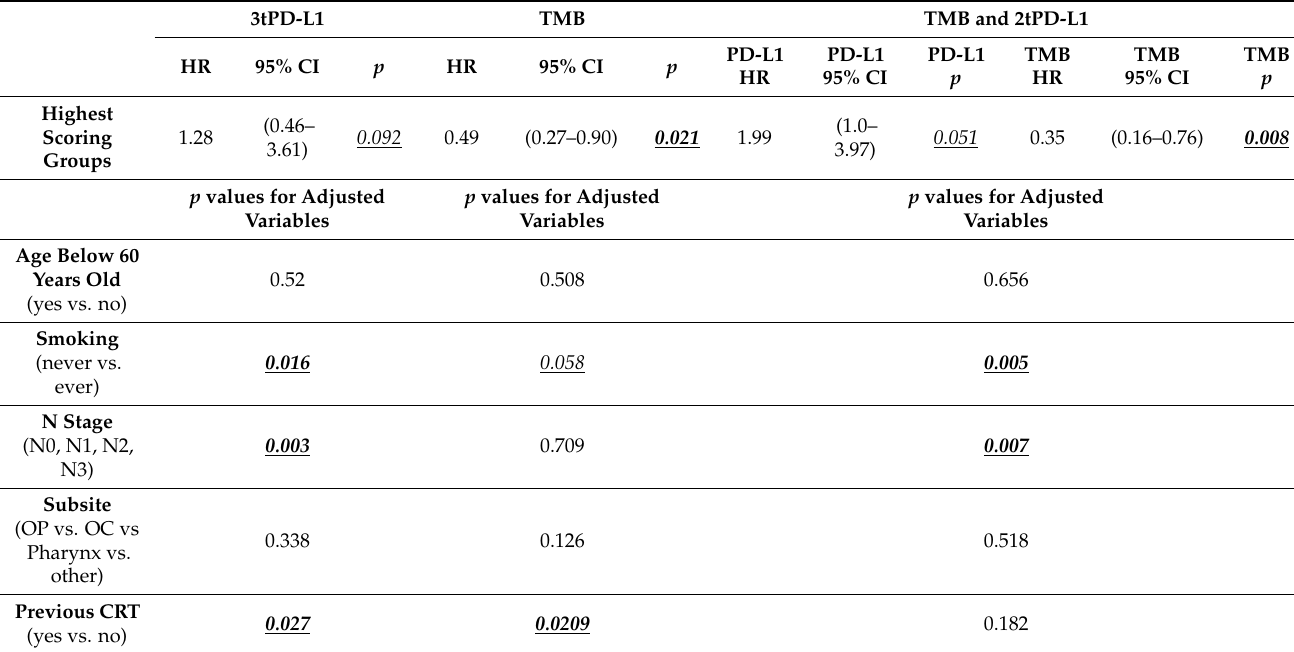
Table 4. Results from adjusted Cox proportional hazard regression models of impact of the presence of PD-L1 and TMB on overall